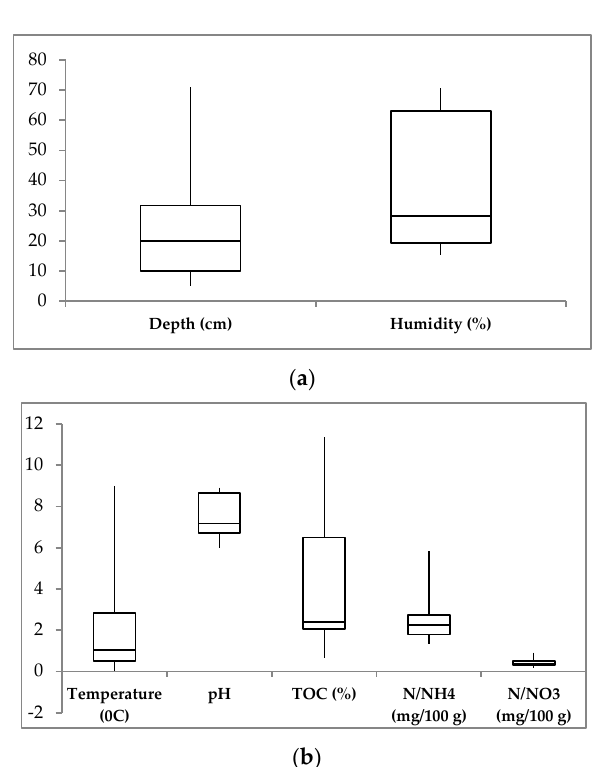
Figure 2. Boxplots of environmental variables for the sampling sites. ( a ) Depth (cm) and humidity (%) of soil sampling; ( b ) TOC (%), soil total carbon; N/NH 4 (mg/100 g fresh soil), soil ammonium nitrogen; N/NO 3 (mg/100 g fresh soil), soil nitrate nitrogen.